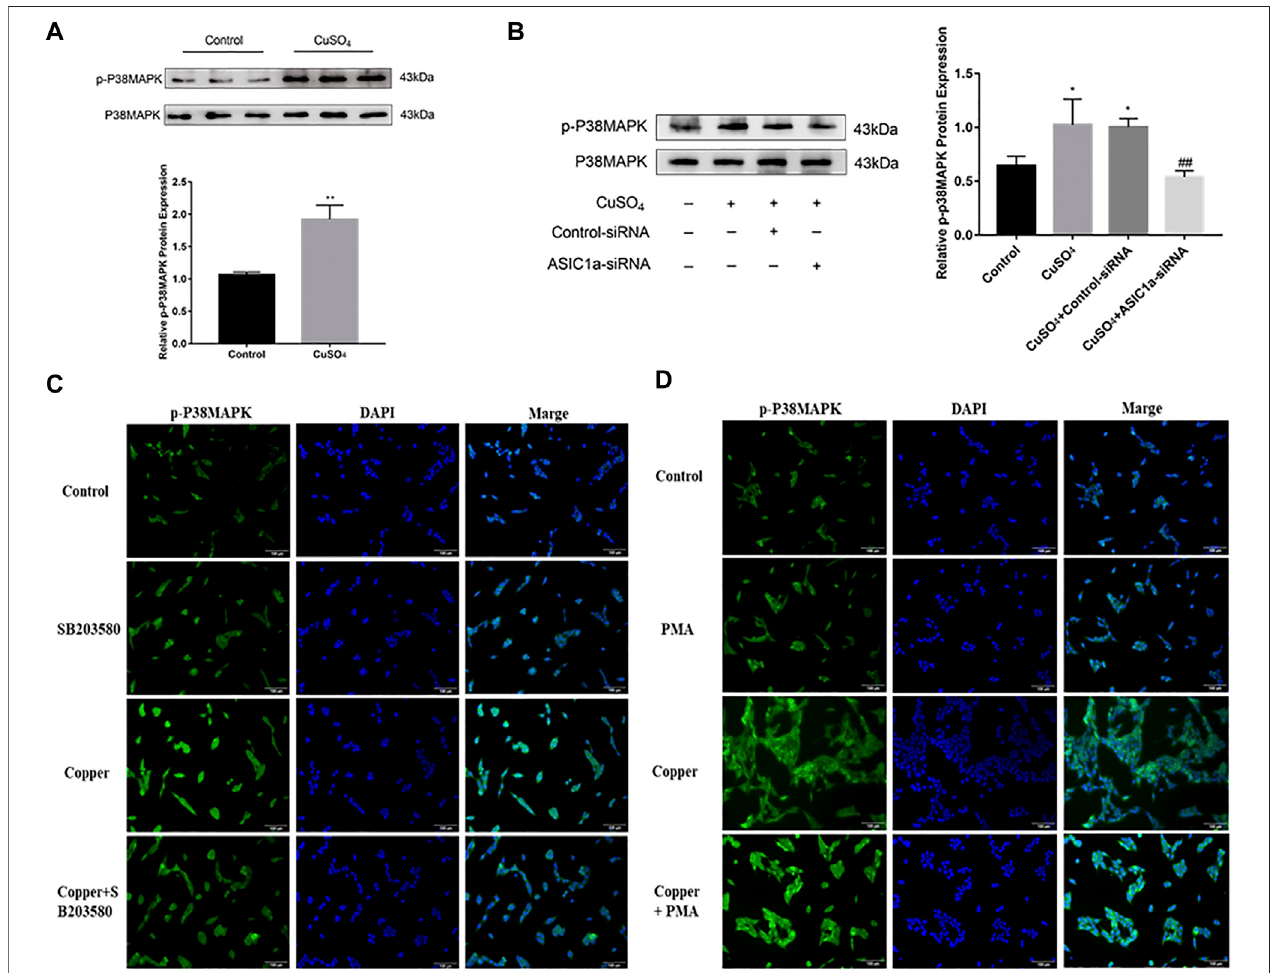
FIGURE 5 | ASIC1a is involved in regulating the phosphorylation of P38MAPK under copper accumulation conditions (A) Protein expression of phosphorylated P38 MAPK in copper-treated HSC-T6 cells. Data are expressed as the mean ± SEM ( n (cid:2) 6). * p < 0.05, ** p < 0.01 vs. Control group (B) Copper-induced changes in the level of phosphorylated P38MAPK in HSCs transfected with ASIC1a-siRNA. Data are expressed as the mean ± SEM ( n (cid:2) 4). * p < 0.05, ** p < 0.01 vs. Control group; fl uorescencedetectionofcopper-inducedphosphorylationofP38MAPKinhepaticstellatecellstreatedwiththe # p < 0.05, ## p < 0.01vs.CuSO 4 group (C) Immuno P38MAPKpathwayinhibitorSB203580.(magni fi cation200 × ) (D) Immuno fl uorescencedetectionofcopper-inducedP38MAPKphosphorylationinhepaticstellatecells treated with the P38 MAPK pathway agonist dehydrocorydaline (PMA) (magni fi cation 200 ×